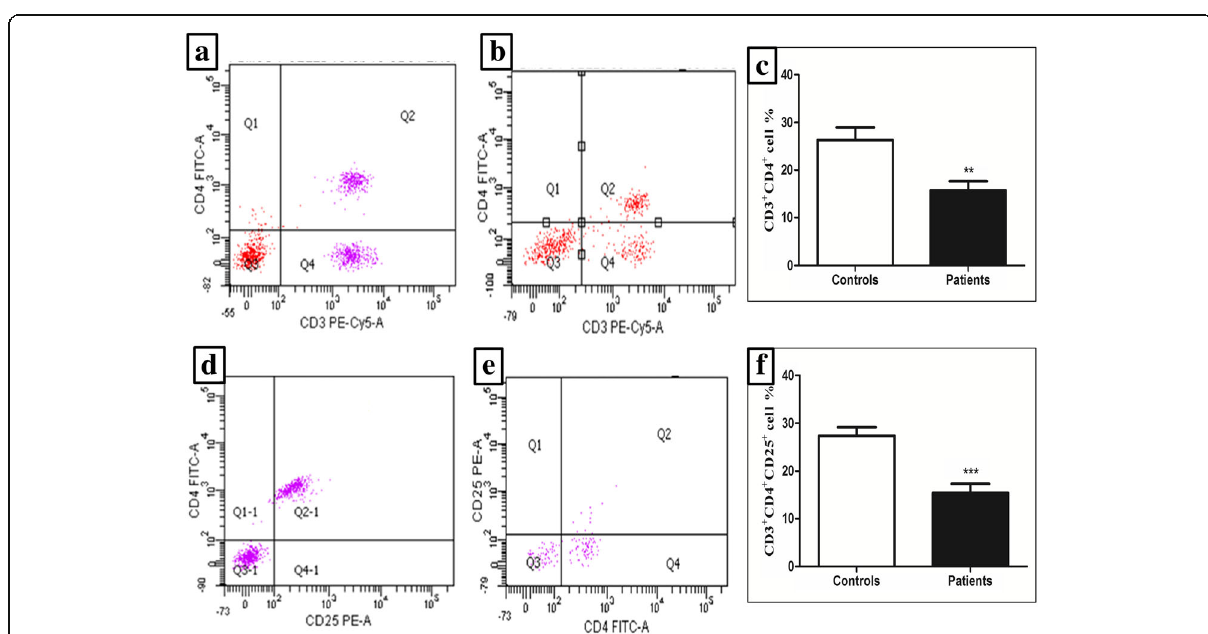
Fig. 3 a Dot plot of CD3 + CD4 + T cells in controls ( b ) Dot plot of CD3 + CD4 + T cells in patients ( c ) Statistical analysis of CD3 + CD4 + T cells in controls and patients ( d ) Dot plot of CD3 + CD4 + CD25 + T cells in controls ( e ) Dot plot of CD3 + CD4 + CD25 + T cells in patients ( f ) Statistical analysis of CD3 + CD4 + CD25 + T cells in controls and patients. All values are calculated as Mean ± SD. ** p < 0.01; *** p < 0.001